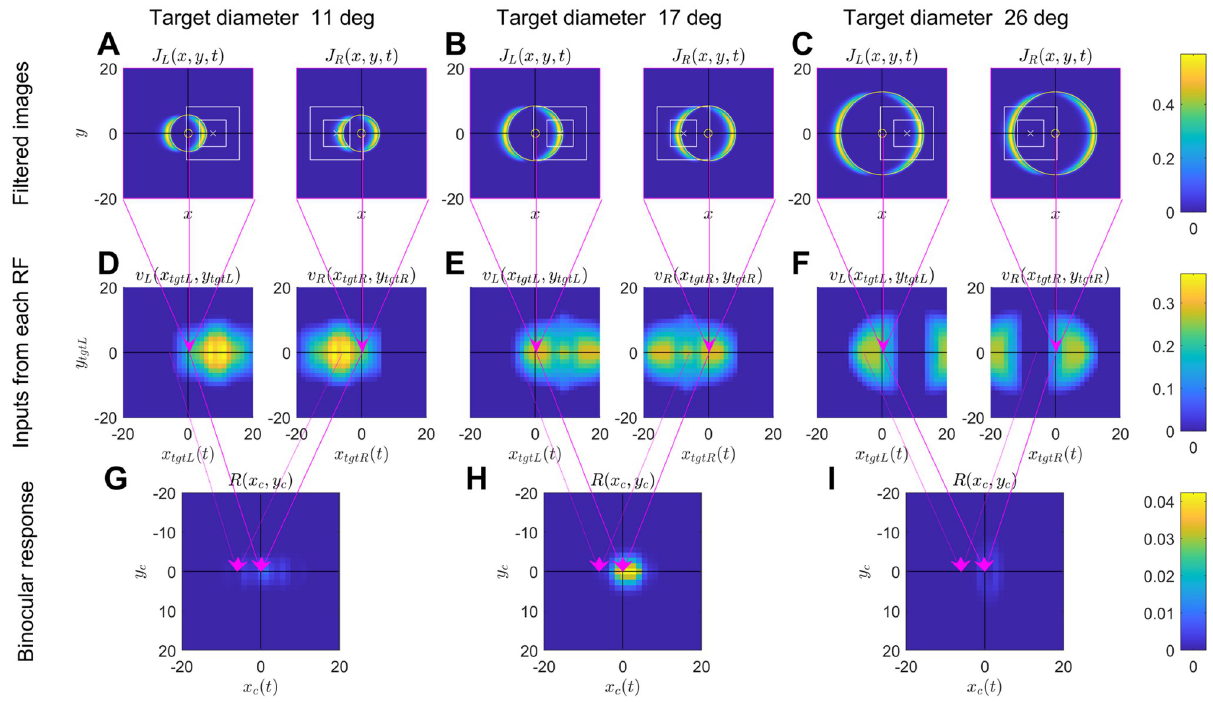
Fig 14. As for Fig 12, but for a target at a simulated distance of 10cm from the mantis (zero screen disparity).